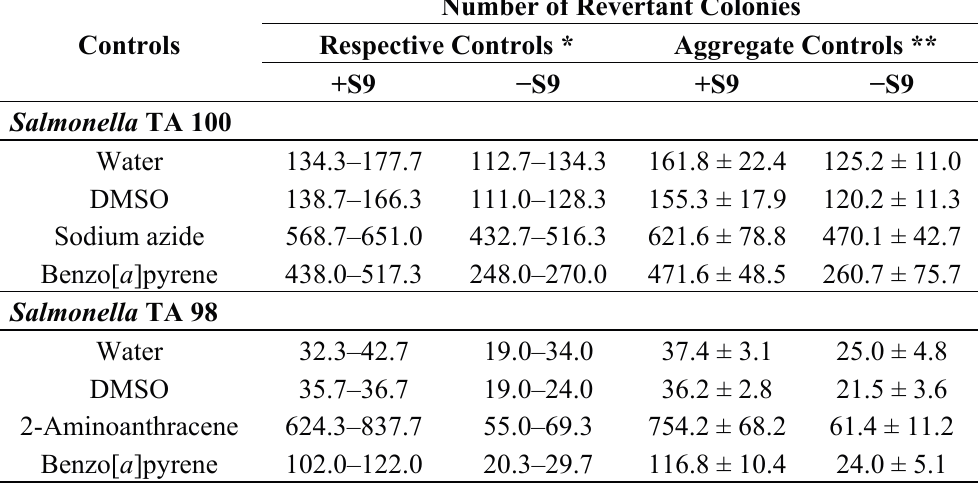
Table 1. Ranges for revertant colonies obtained with control substances in the standard plate incorporation